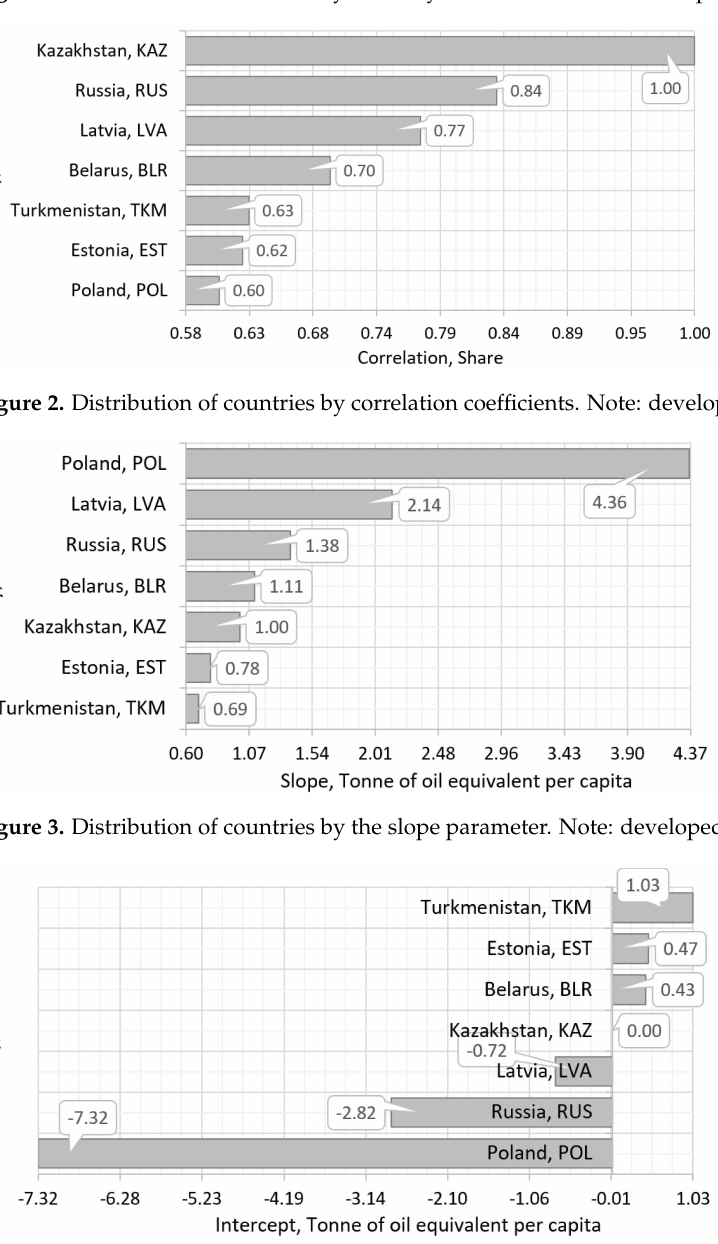
Figure 1. Distribution of countries by elasticity coefficients. Note: developed by the authors.